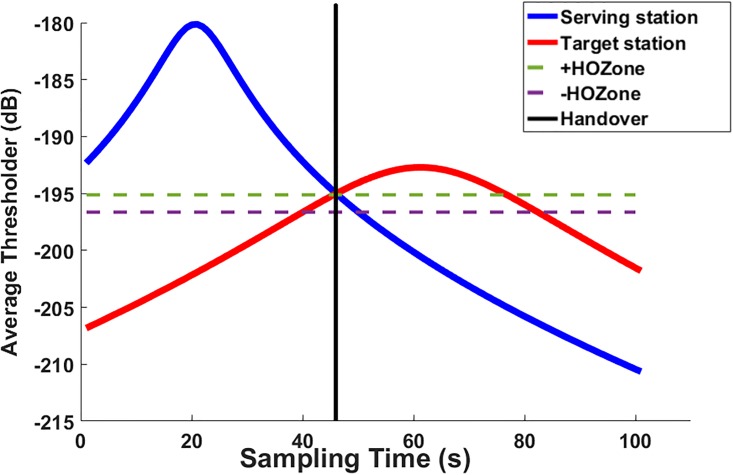
Normal handover.